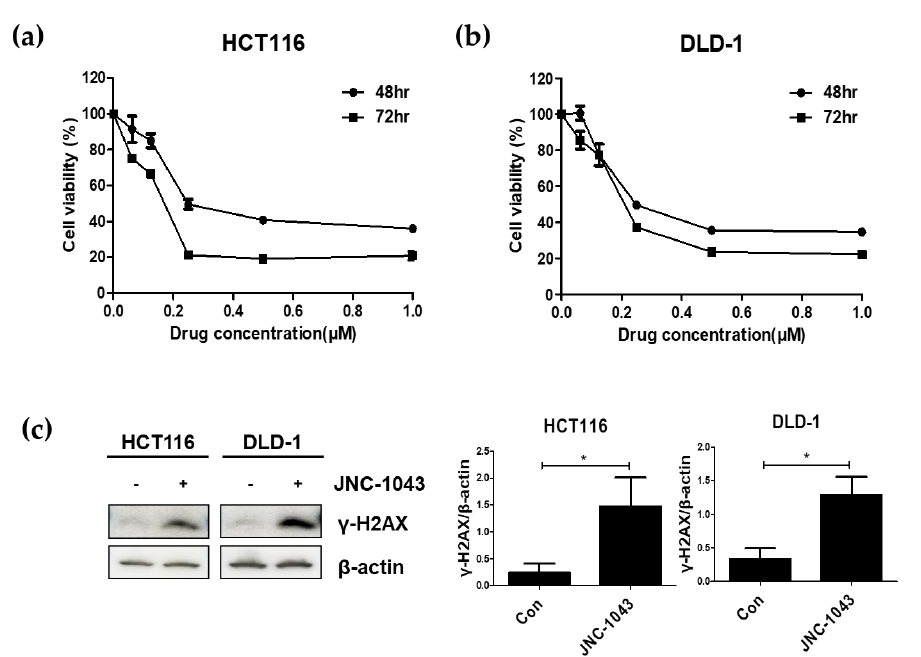
Figure 2. Anticancer effect of JNC-1043. The CRC cell lines, HCT116 ( a ) and DLD-1 ( b ), were treated with 62.5, 125, 250, 500, and 1000 nM JNC-1043 for 48 or 72 h, and cell viability was measured with the MTT assay. IC50 values for JNC-1043 against CRC cell lines were calculated as described in the Section 4. ( c ) Immunoblot assay for the detection of γ H2AX activation in cells treated with JNC-1043. HCT116 and DLD-1 cells were incubated with 110 or 150 nM JNC-1043, respectively, and incubated for 24 h prior to harvesting. The relative band densities were analyzed as described in the Section 4. All experiments were repeated in triplicate, and the bands in the figures show representative data. * p < 0.05. Table 1. IC50